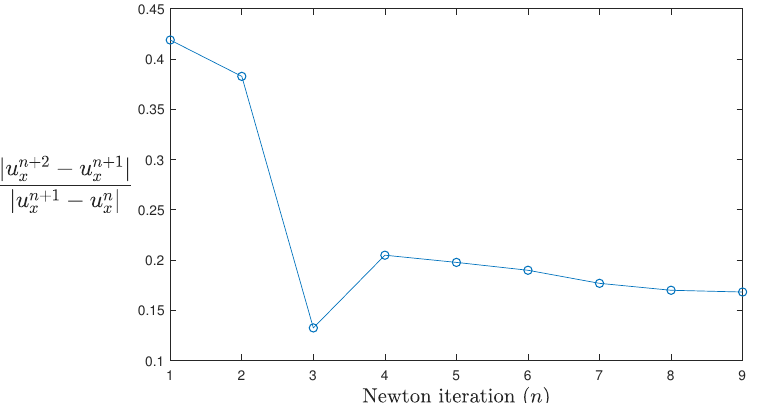
Figure 23. Ratio of the convergence of the Newton’s method for R = 1300, Γ = 3.495, np = 2, mp = 1, N × M = 16 ×